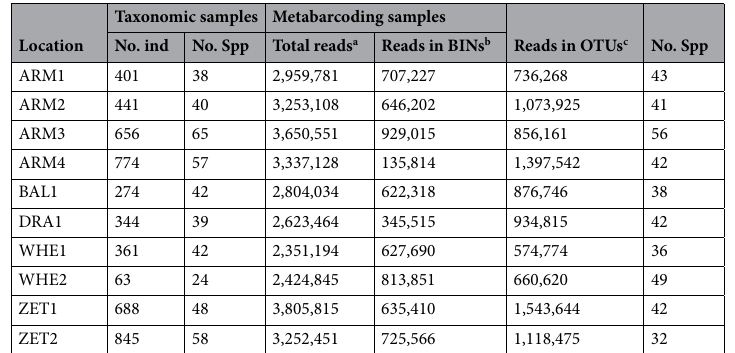
Location Reads in OTUs c No. SppNo. ind No. Spp Total reads a Reads in BINs